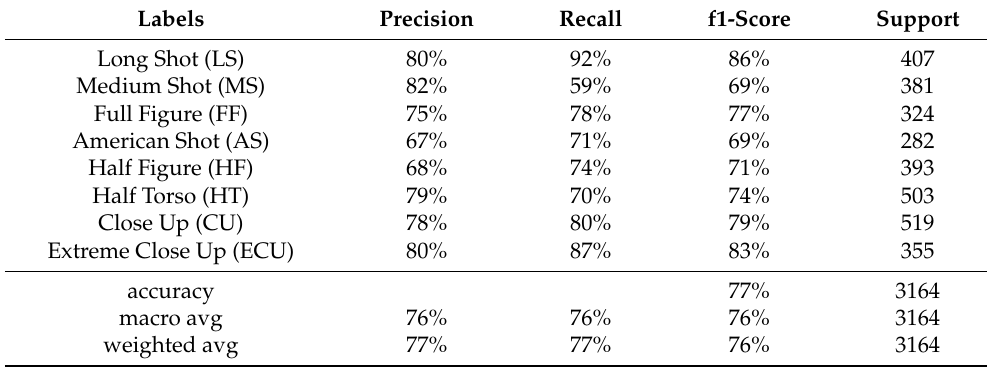
Table 9. Precision recall and f1-score of a VGG-16 trained on the augmented Original Dataset with the flip on the y-axis, i.e., Scenario